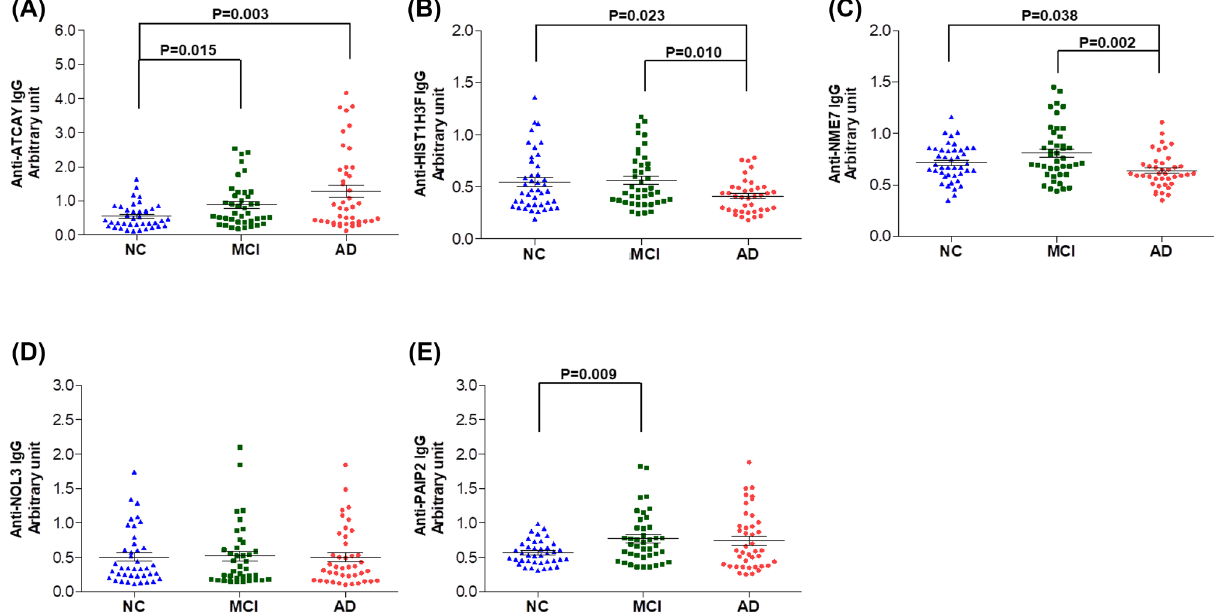
Figure 2. Levels of serum autoantibodies in the AD, MCI and cognitively normal control groups. Serum levels of anti-ATCAY IgG ( A ), anti-HIST1H3F IgG ( B ), anti-NME7 IgG ( C ), anti-NOL3 IgG ( D ), and anti-PAIP2 IgG ( E ) were indicated as an arbitrary unit which was defined as optical densities normalized by signals from the human whole IgG. Statistical significance was calculated by Mann–Whitney test after removing outliers that were more than 1.5 × interquartile range (IQR). Bars show mean ± standard error of the mean (SEM).